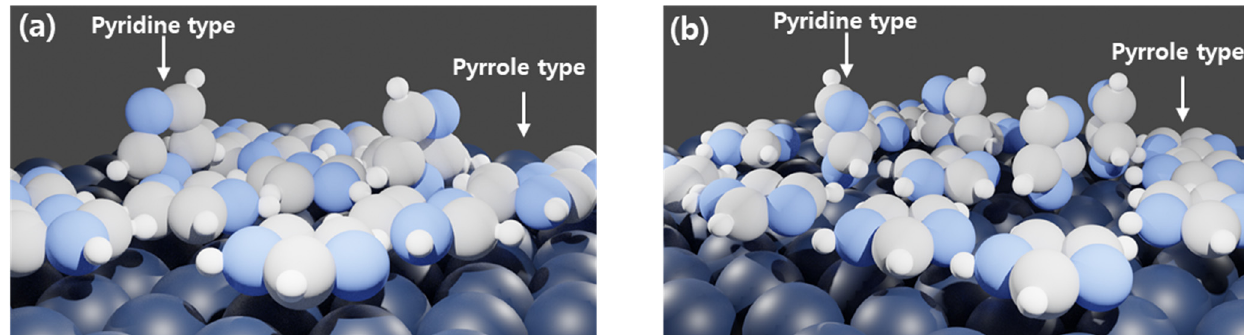
Figure 9. Schematic view of imidazole adsorption at different concentrations of imidazole: ( a ) 500 ppm; ( b ) 1000 ppm.